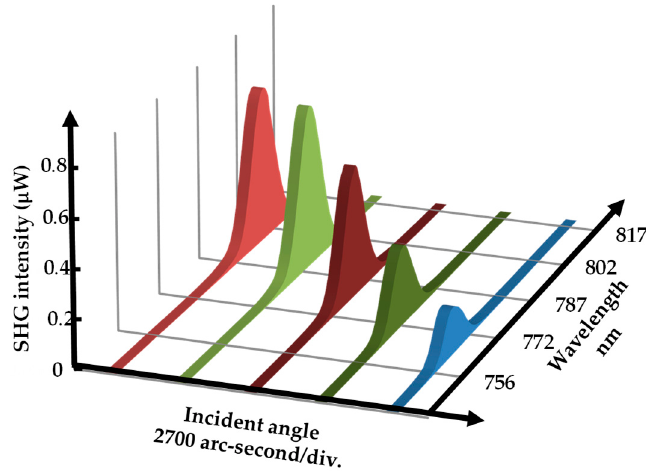
Figure 7. Characteristic of SHW spectra in different incident angles using LiNbO 3 crystal. Table 4. Rotary stage characteristics.